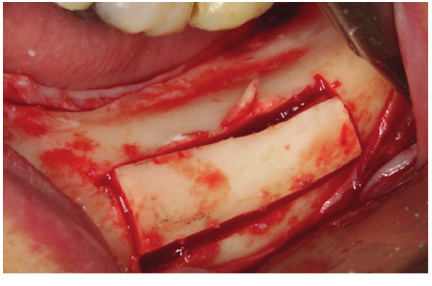
Figure 9: Placement of absorbable membrane.